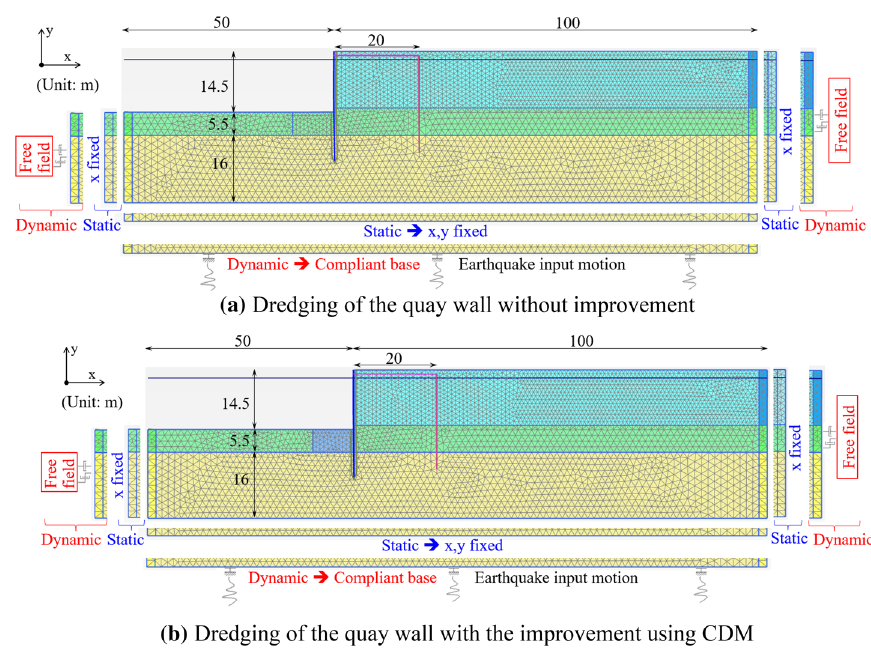
Fig. 2 Finite element models of the renovated quay